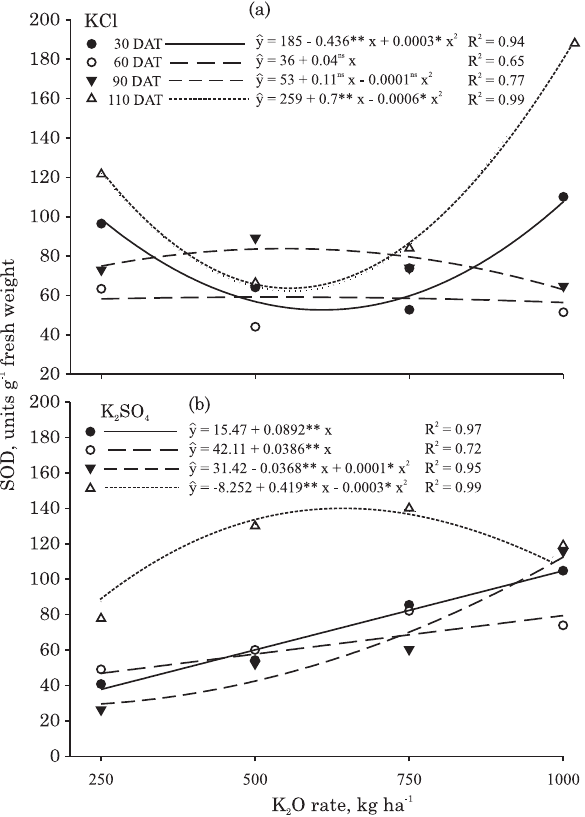
Figure 3. Effect of K sources and rates on superoxide dismutase (SOD) activity in eggplant leaves at 30, 60, 90, and 110 days after transplanting